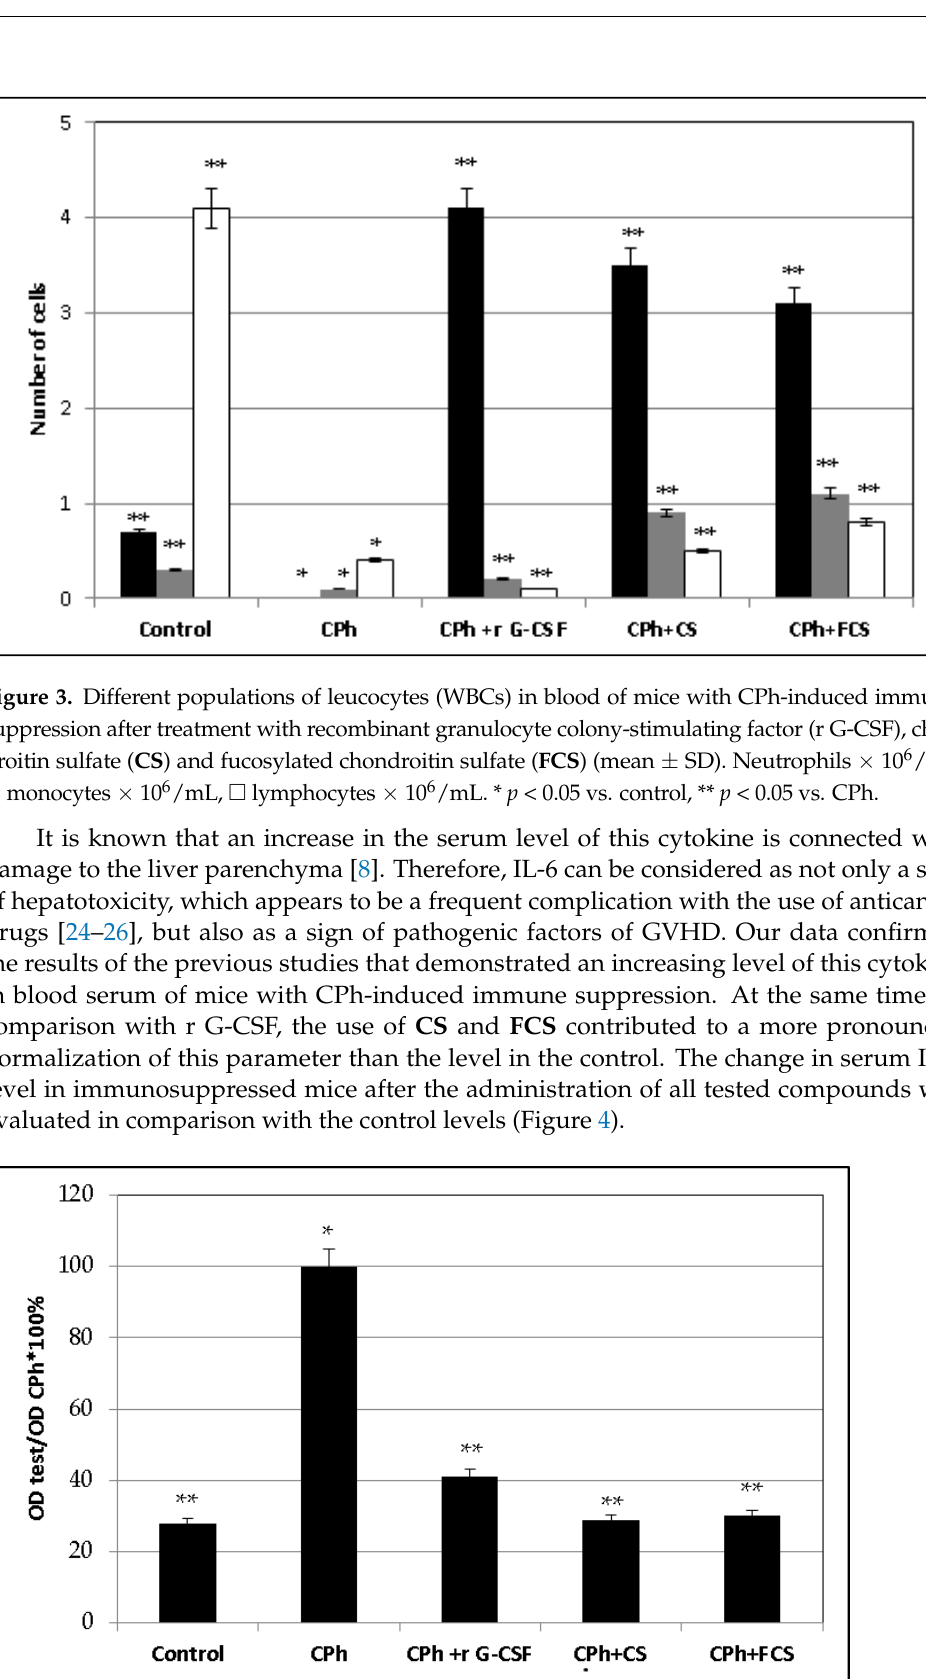
E Figure 5. Spleen fingerprints of mice with CPh-induced immunosuppression after treatment with tested compounds (he- matoxylin–eosin staining). ( A ) Control, ( B ) CPh, ( C ) CPh-r G-CSF, ( D ) CPh- CS , ( E ) CPh- FCS . Original magnification ×400. Special experiments were carried out in vitro in order to clarify the mechanism of action of CS and FCS . Bone marrow cells from healthy mice were incubated ex vivo in a nutrient medium containing the cytostatic agent cisplatin (Cis), r G-CSF, CS , FCS or a combination thereof (Cis-r G-CSF, Cis- CS and Cis- FCS ) for 2 days. Intact cells were used as a control. Cisplatin was chosen as a cytostatic agent because it is a component of most combinations of chemotherapeutic drugs used to treat cancer patients [2]. In addition, un- like CPh, it is capable of exerting a cytotoxic effect without additional transformation in the patient's body. After 2 days of incubation, the number of living cells and the level of their proliferation were assessed using flow cytometry (Figures 6–8). It was shown that similarly to r G-CSF, CS and FCS increased the number of living cells following cisplatin exposure and stimulated their proliferation (increasing the number of Ki67(+) cells).